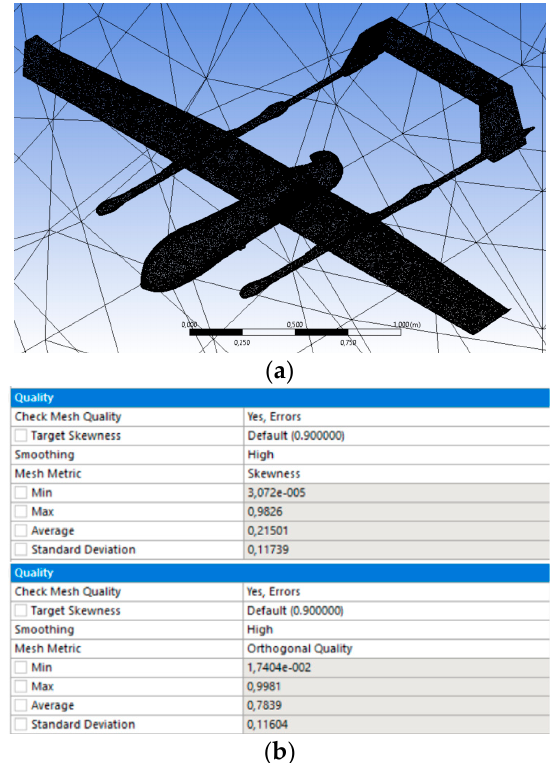
Figure 7. Mesh result: ( a ) VTOL-Plane mesh visualization and ( b ) mesh quality.